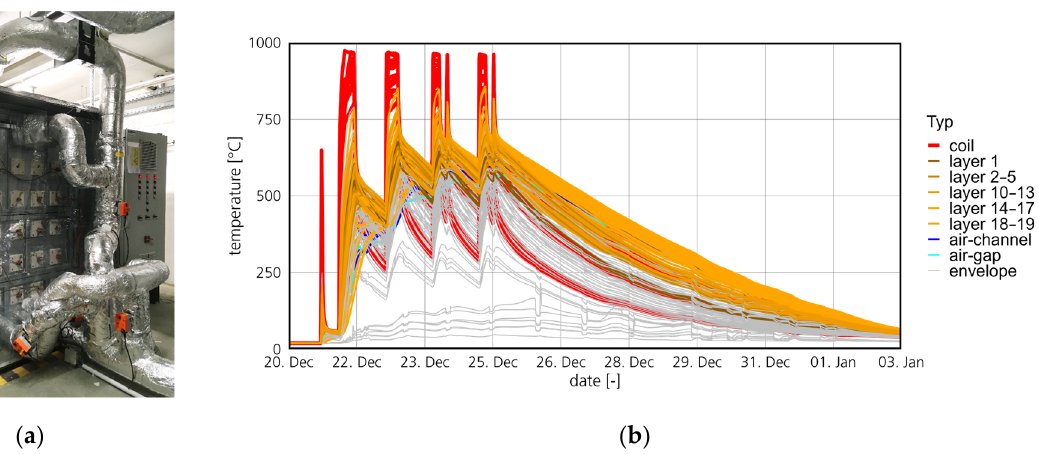
Figure 5. ( a ) Final, full-size HTSS prototype. ( b ) Long charging period with the temperatures of the heating rods (coils) (red) and all thermocouples in the stone core (orange) and the envelope (gray).